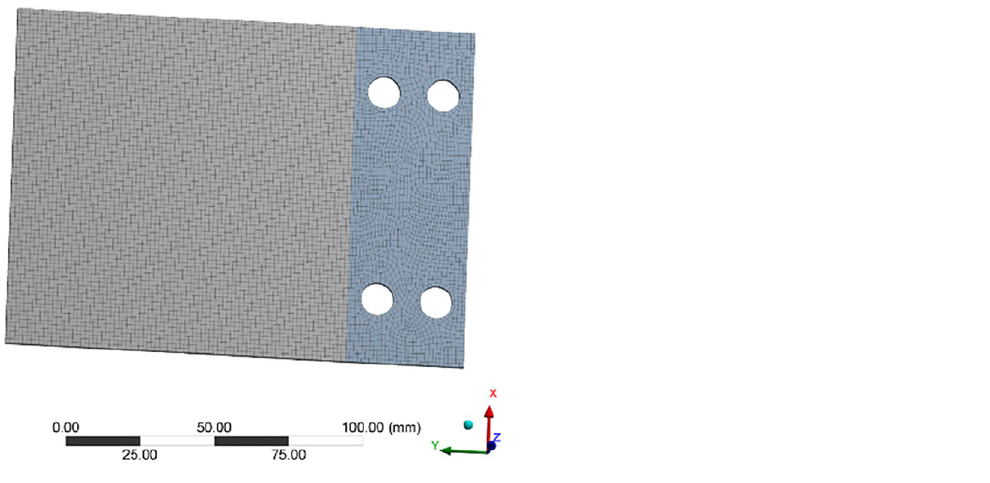
Figure 6. Finite element model of the